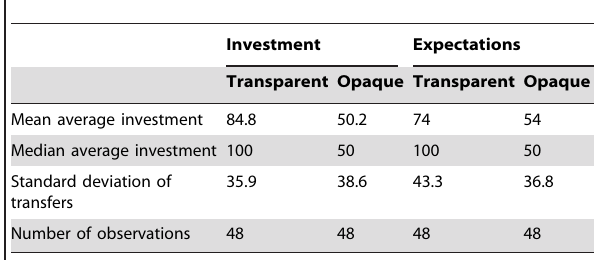
Table 2. In the transparent condition participants’ investment is 34.6% higher than in the opaque condition, and the median investment is 100, compared to a median of only